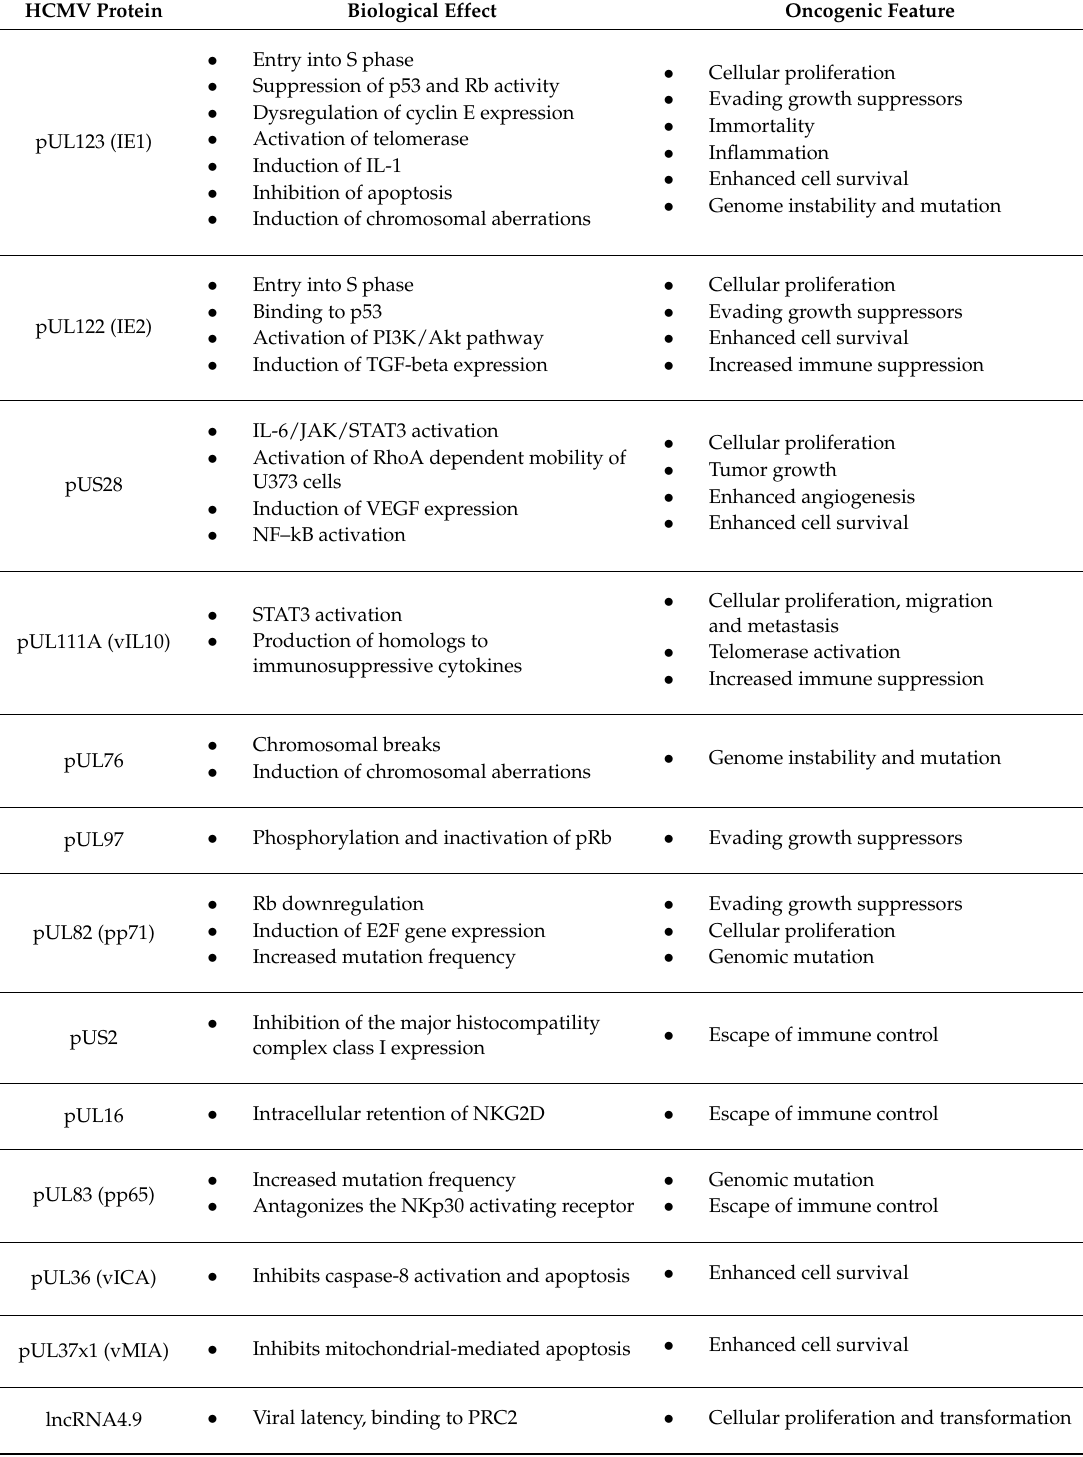
Table 1. Human cytomegalovirus (HCMV) products with oncogenic